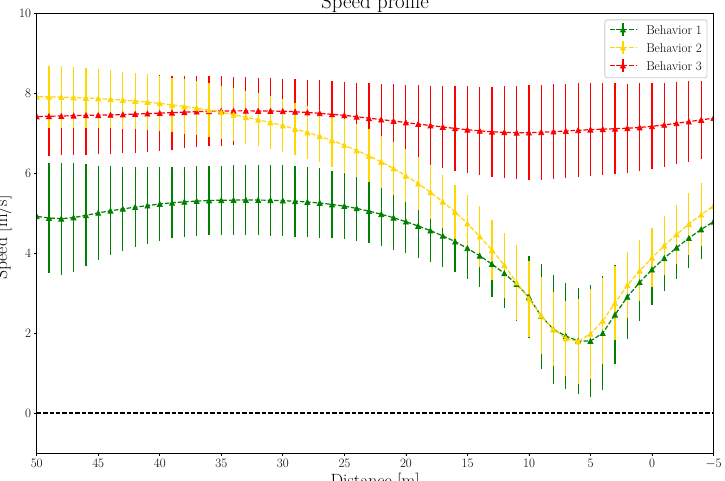
Figure 10. Results of the cluster analysis using the K-Mean algorithm on the collected speed profiles. The red, yellow and green lines represent the average speed profiles of the clusters. The vertical bands show the standard deviations of vehicle speed at each